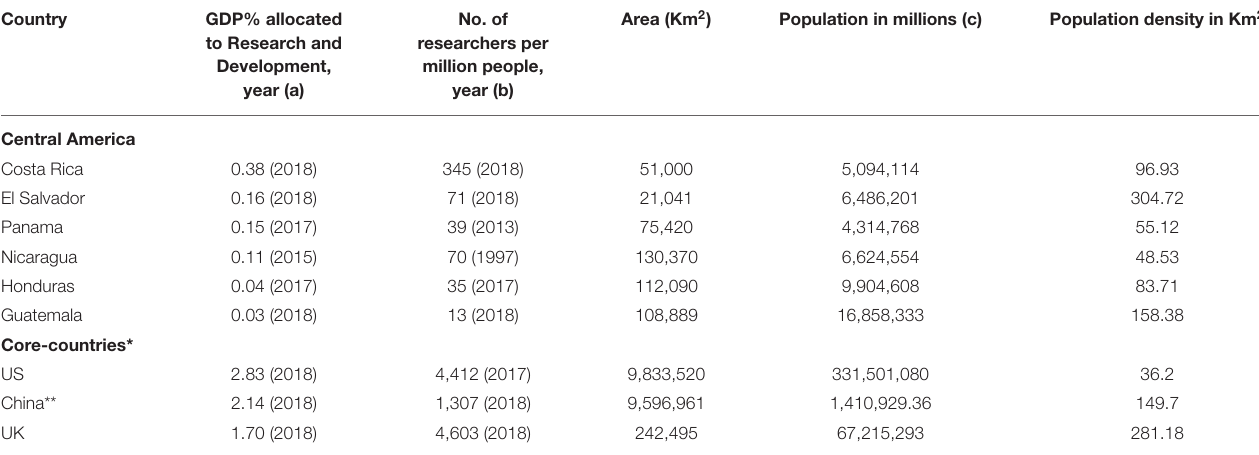
TABLE 5 | Funds assigned for research in Central America.